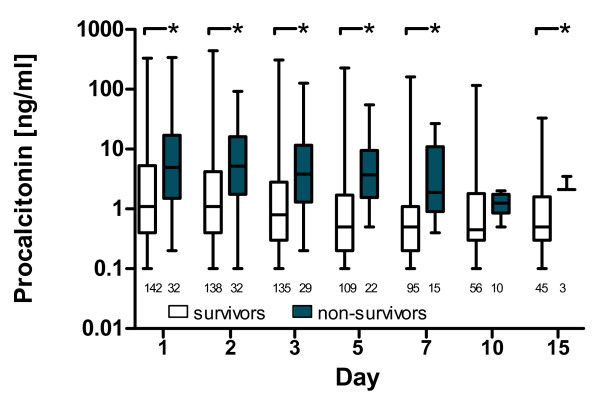
Time course of procalcitonin levels in patients with pneumonia depending on survival. Box plot representing the time course of PCT over the two weeks following study enrolment in survivors and non-survivors. * P < 0.05 compared with survivors.